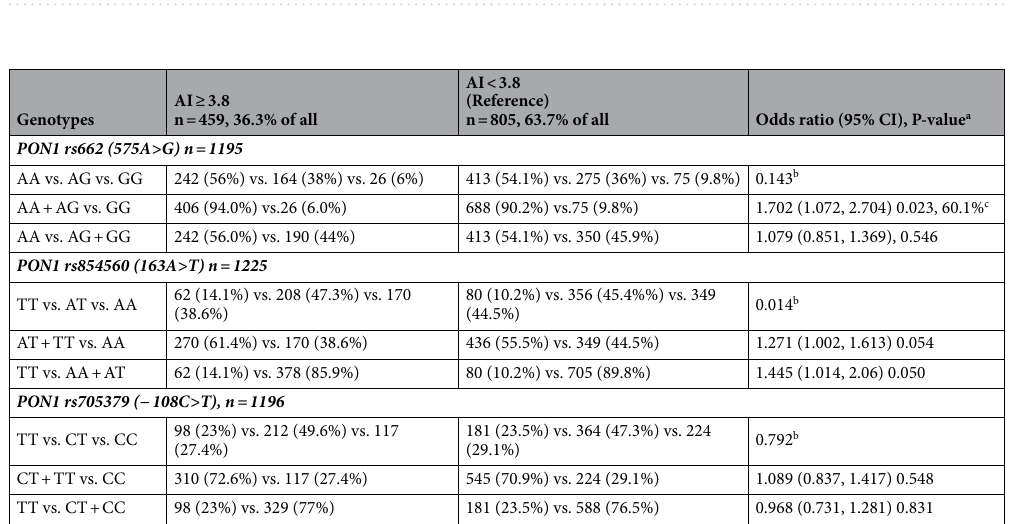
Table 3. PON1 polymorphic variants and atherogenic dyslipidaemia diagnosed by the atherogenic index ≥ 3.8. a Fisher’s exact test. b Cochran-Armitage test. c Sample power for this